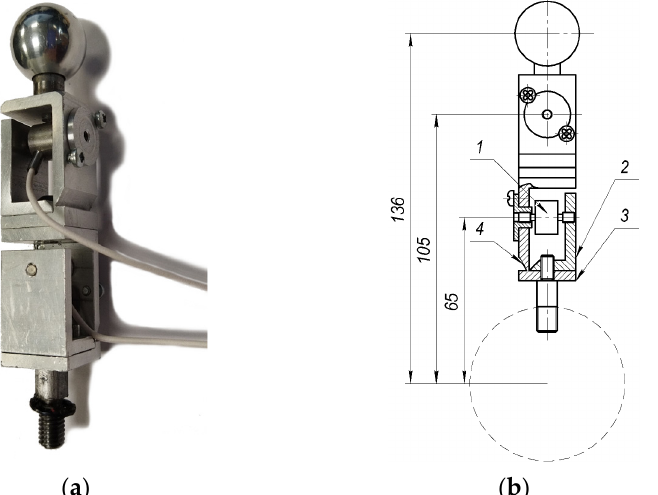
Figure 6. Haptic device handle: ( a ) practical implementation; ( b ) blueprints: 1 sensor, 2 static part of the sensor frame, 3 movable part of the sensor frame, 4 slot.